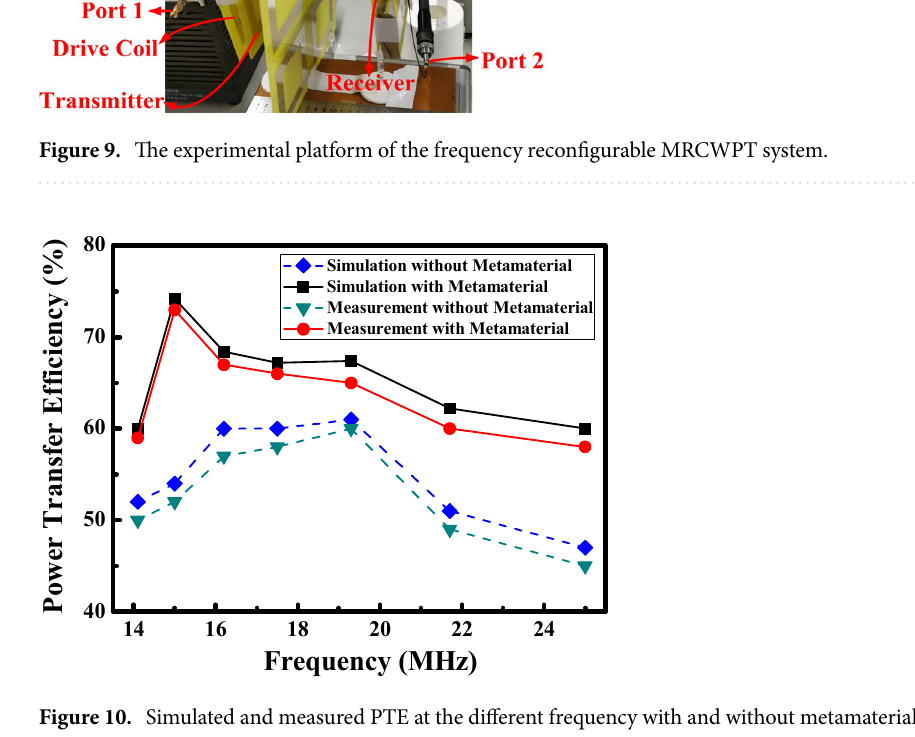
Figure 10. Simulated and measured PTE at the different frequency with and without